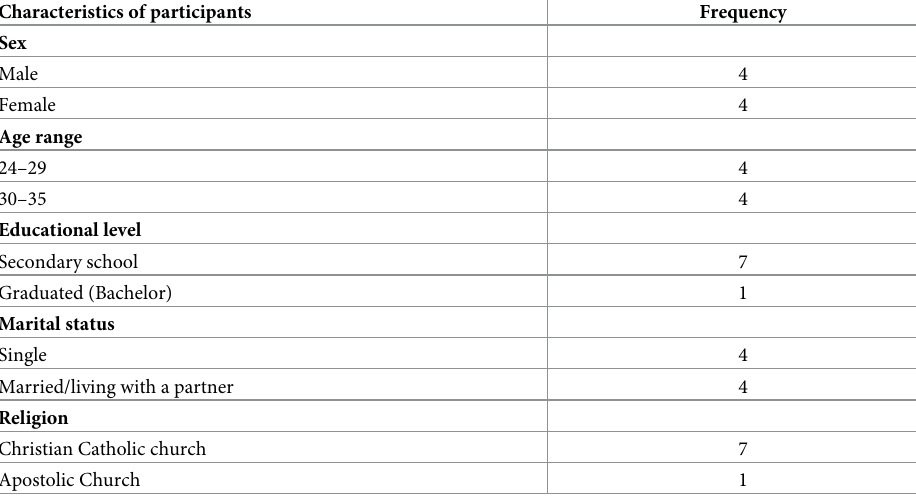
Table 5. Sociodemographic characteristics of data